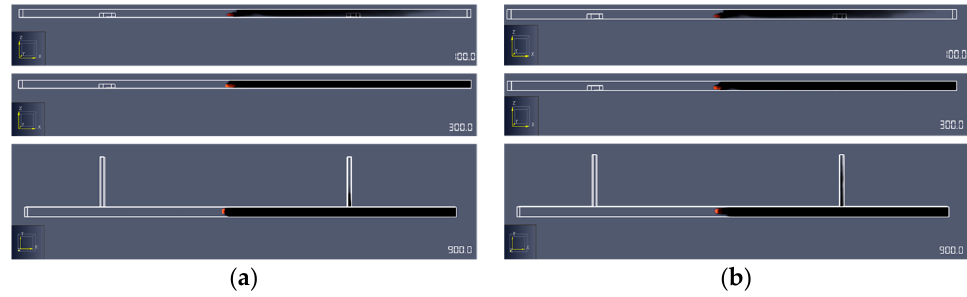
Figure 5. Flue gas di ff usion diagrams at 3.6 m/s under di ff erent fi re scales (the ventilation velocity of the transverse passageway was 0 m/s): ( a ) 5 MW; ( b ) 20 MW.